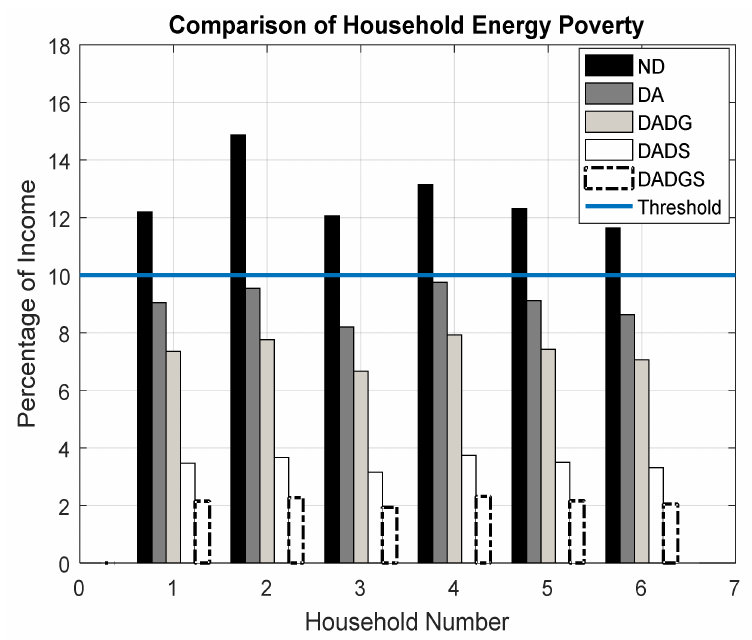
Figure 5. Comparison of household energy